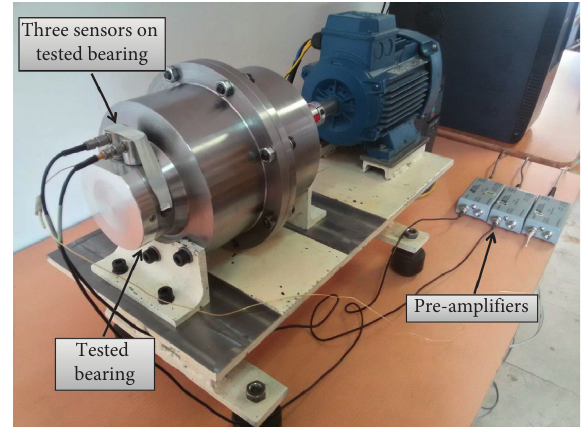
Figure 5: The setup with sensors and preamplifiers.